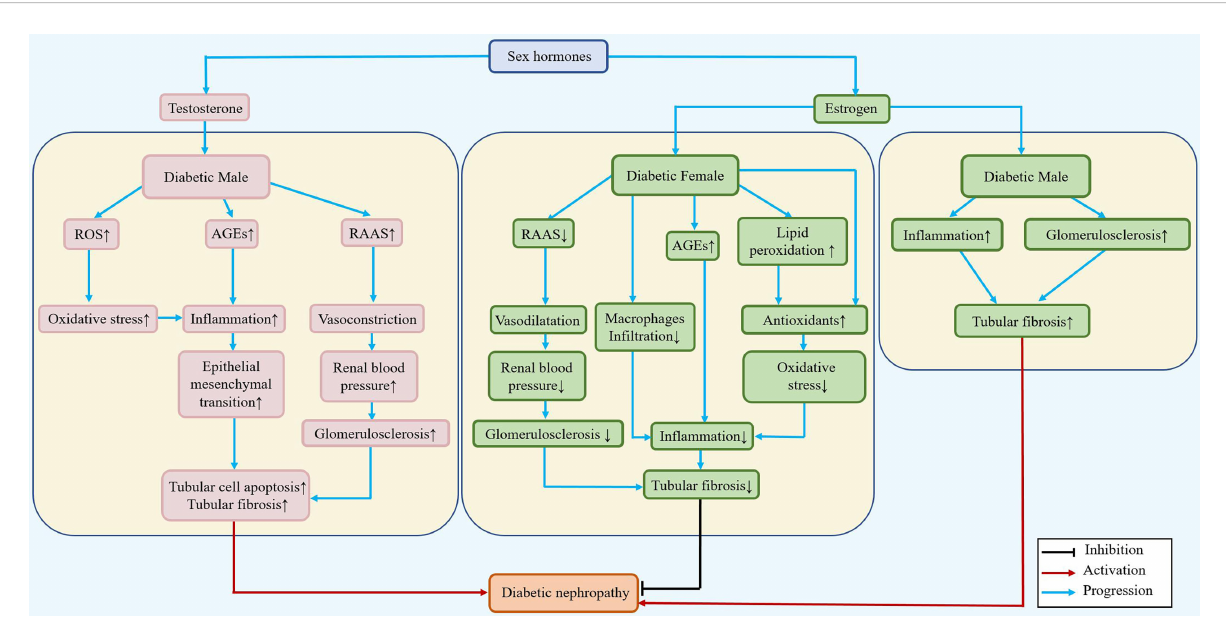
FIGURE 2 Differential roles of estrogen/testosterone in the pathogenesis of DN. During diabetes, testosterone can increase the renal blood pressure and in fl ammatory response, accelerate the epithelial mesenchymal transition, and lead to renal tubular fi brosis in males. In females, estradiol can reduce renal tubular fi brosis by reducing blood pressure, downregulating the in fl ammatory response and epithelial mesenchymal transition, and playing a renoprotective